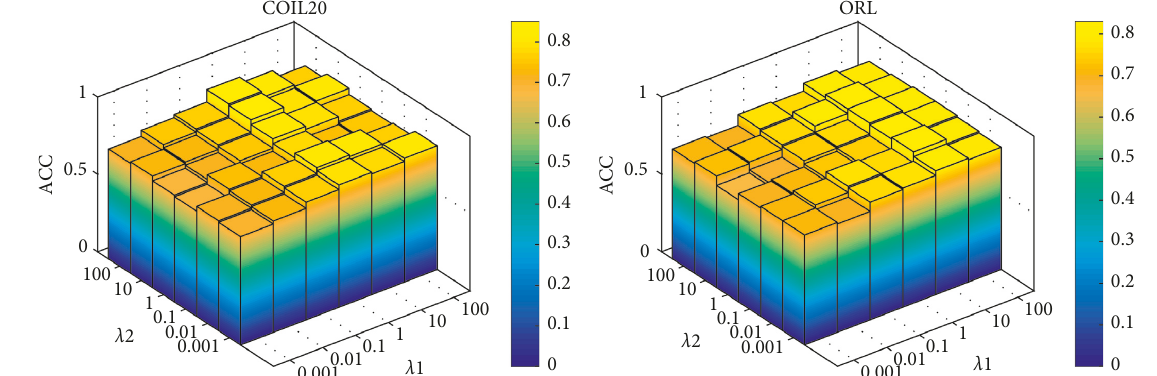
Figure 6: The parameter study of λ